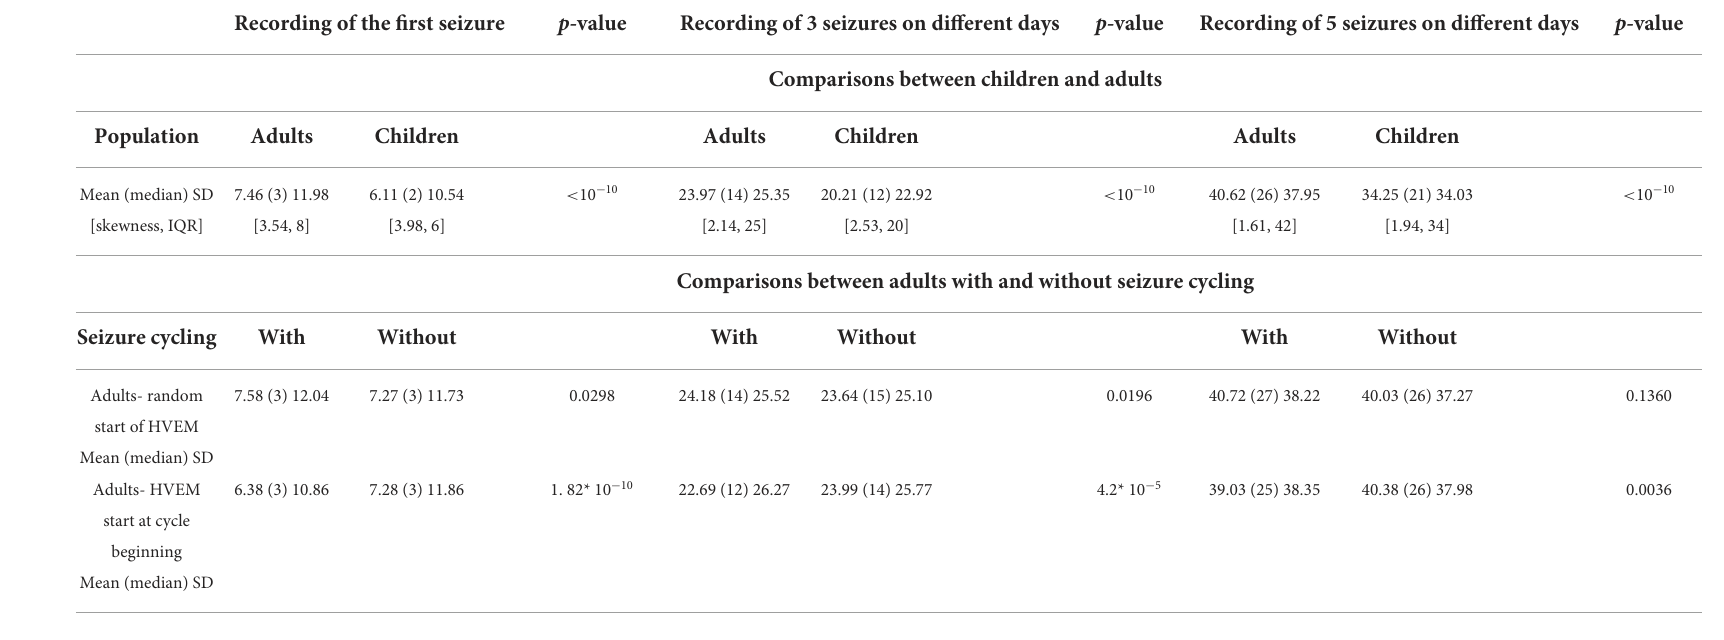
TABLE 1 Comparison of necessary duration of monitoring between various patient populations (expressed in